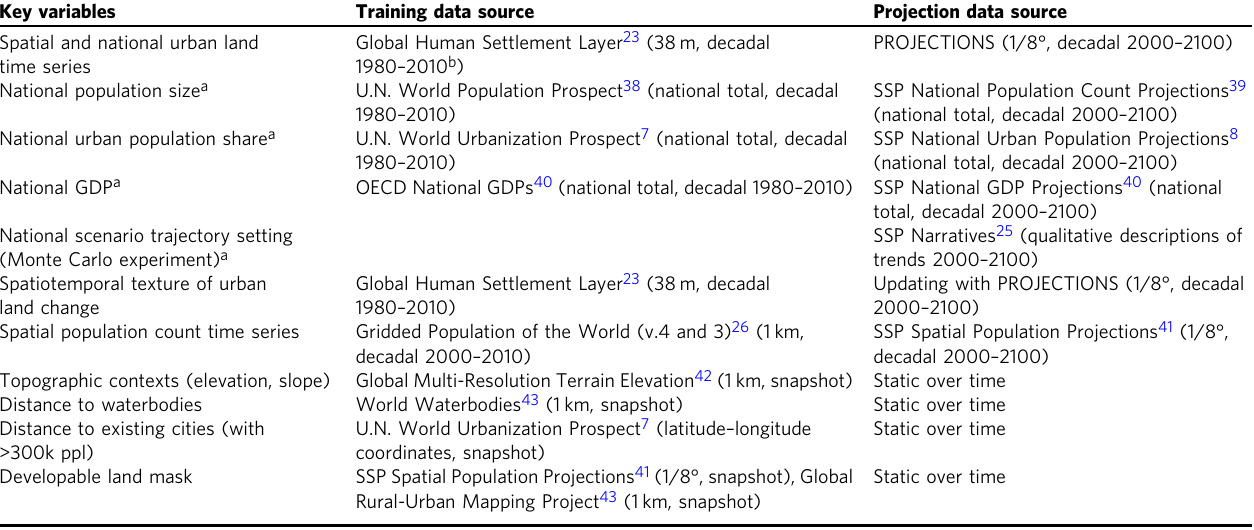
Table 2 Key model variables and their data sources.